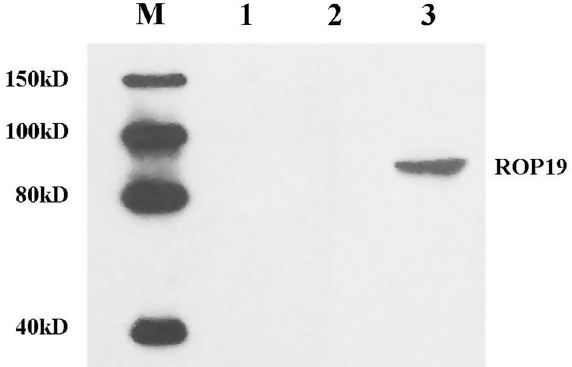
Figure 3. In vitro expression analysis of the constructs in HEK 293- T cells by Western blot. Protein marker (lane M), untransfected cells (lane 1), cells transfected with pEGFP-C1 (lane 2), and cells transfected with pROP19 (lane 3). The marker contains 150 kD, 100 kD, 80 kD, and 40 kD. The detected band is located between 80 kD and 100 kD.